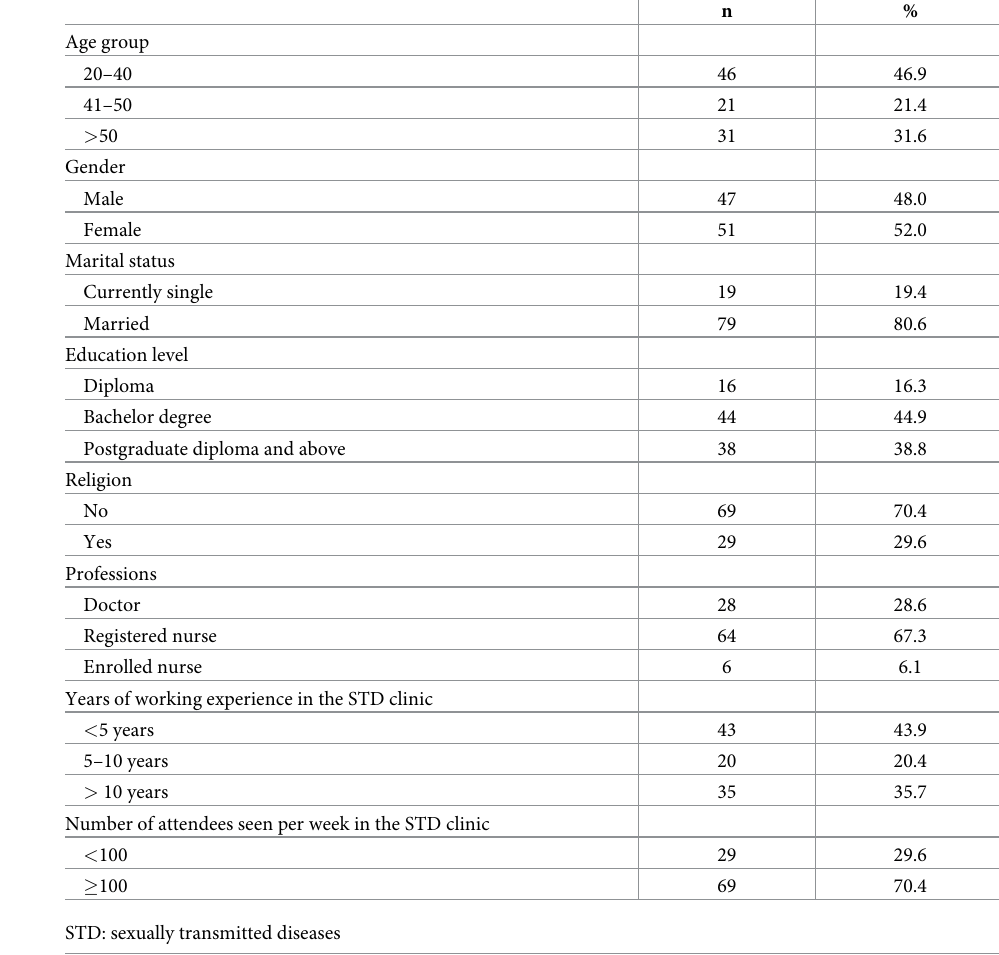
Table 1. Background characteristics of participants (n =